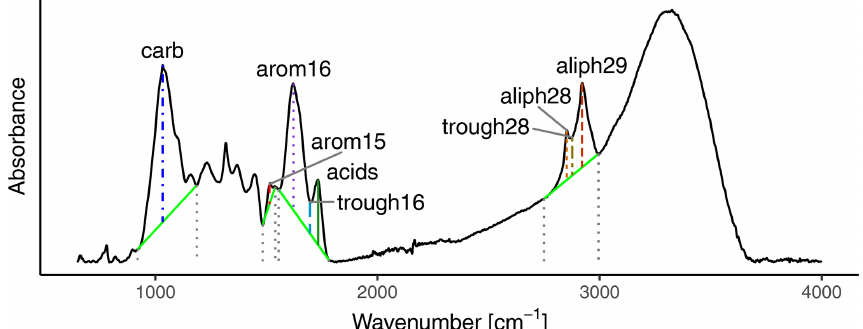
Figure 1. Sample spectrum with the peaks and troughs, their heights, and their baselines (green) as detected by the script developed by Hodgkins et al. (2018). The plot was created with the data and code from Hodgkins et al. (2018) as implemented in ir and irpeat,